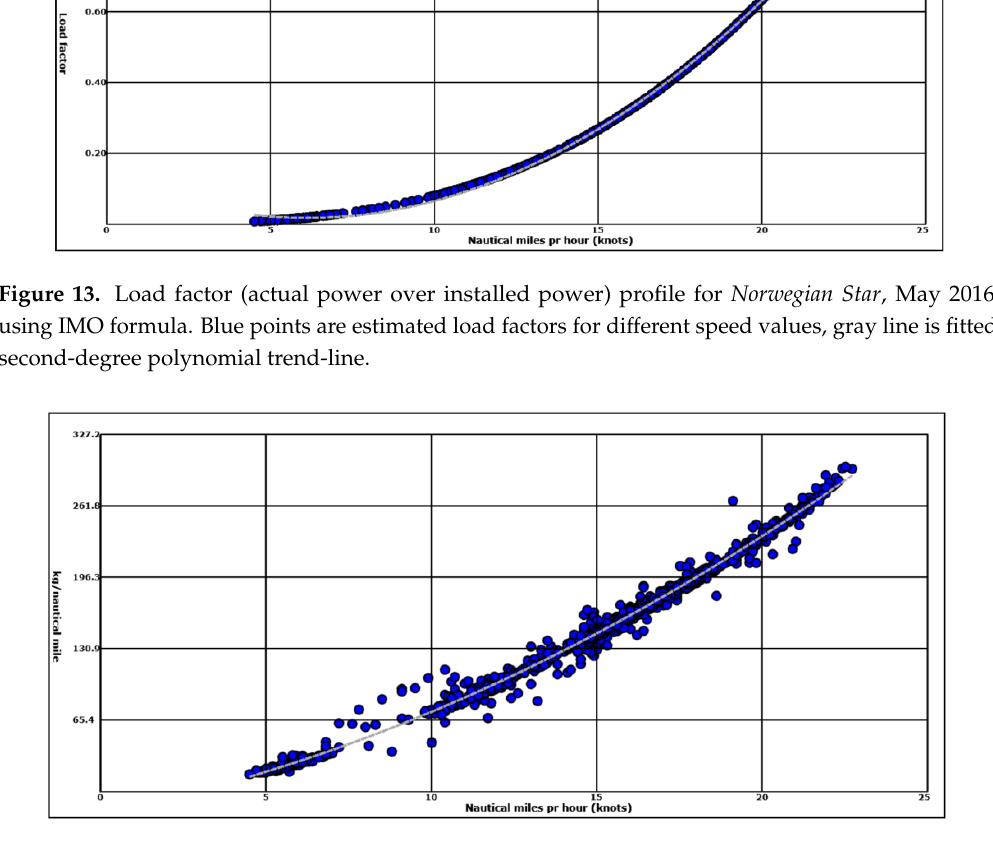
Figure 14. Propulsion fuel profile for Norwegian Star , May 2016 using IMO formula. Blue points are estimated kg/nautical mile for different speed values, gray line is fitted second-degree polynomial trend-line.